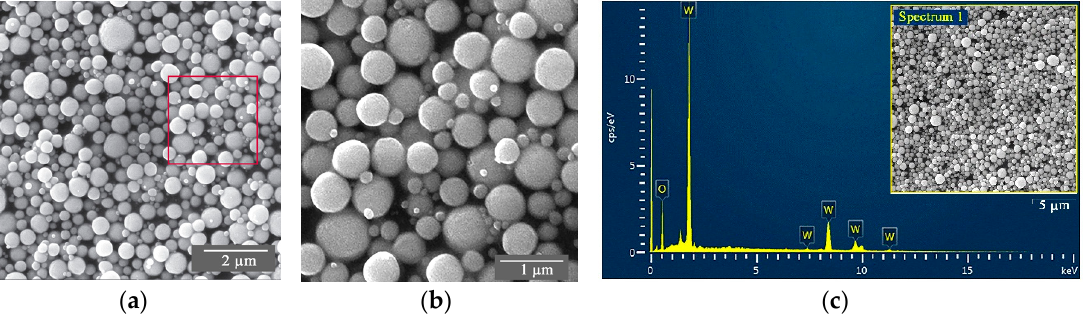
Figure 8. ( a , b ) SEM images and ( c ) EDX spectrum of WO 3 powder synthesized by